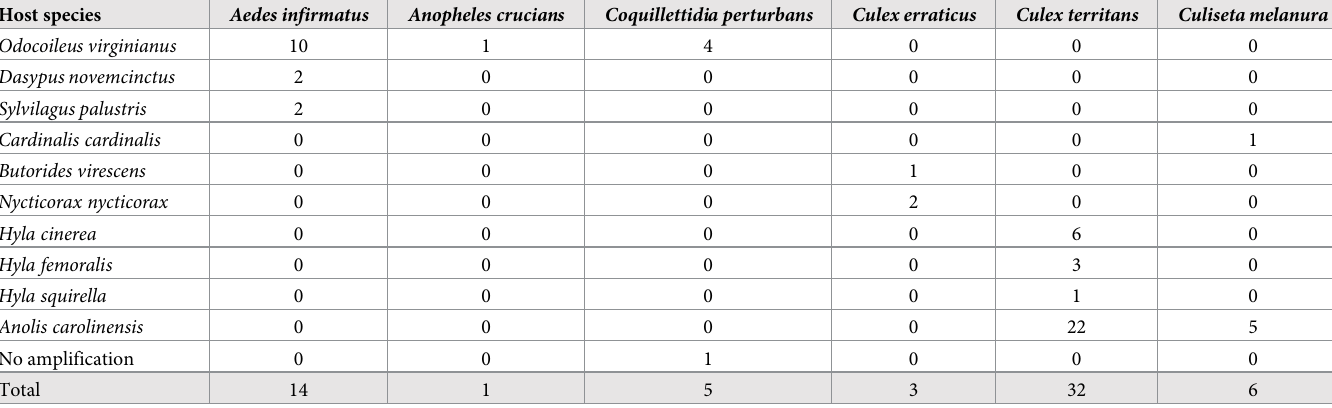
Table 5. Results of blood meal analysis performed using newly designed cytochrome c subunit I